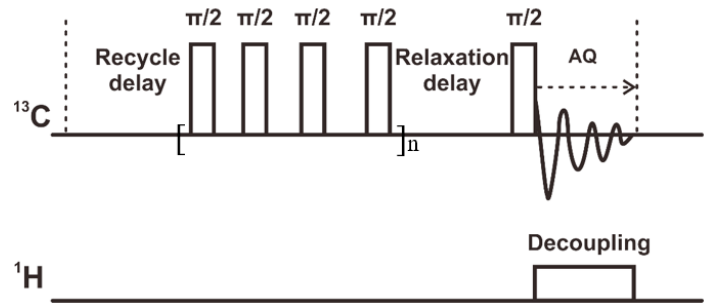
Figure 2. The modified single excitation pulse sequence. The recycle delay was set to 5 s. The